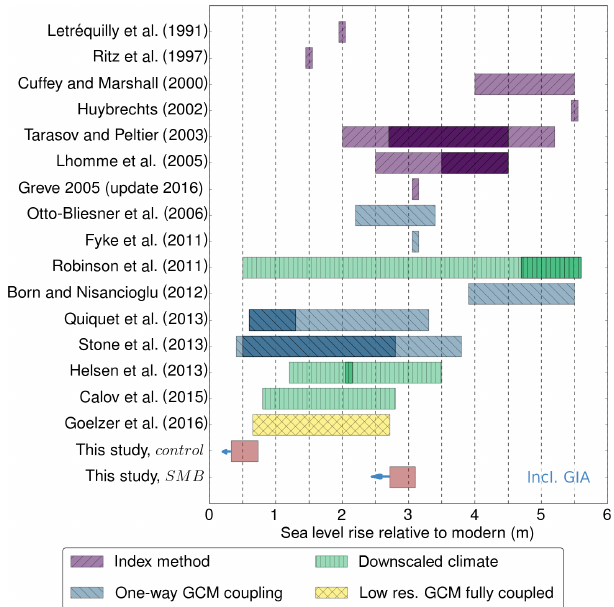
Figure 10. Simulated sea level rise contributions from this study and previous Eemian studies. For this study, the results of the con- trol (MAR-SEB; lower bound) and the SMB experiments (MAR- BESSI; upper bound) are shown (the ranges show the results of the respective basal/outlets fraction sensitivity experiments). Previ- ous studies are color coded according to the type of climate forcing used. More likely estimates are indicated with darker colors if pro- vided in the respective studies. A common sea level rise conversion (distributing the meltwater volume equally on Earth’s ocean area) is applied to Greve (2005), Robinson et al. (2011), Born and Ni- sancioglu (2012), Quiquet et al. (2013), Helsen et al. (2013), and Calov et al. (2015). Tendencies of a GIA inclusion are indicated by blue arrows. The simulations of Greve (2005) were repeated with an updated ice sheet model version in 2016 (Ralf Greve, personal communication,